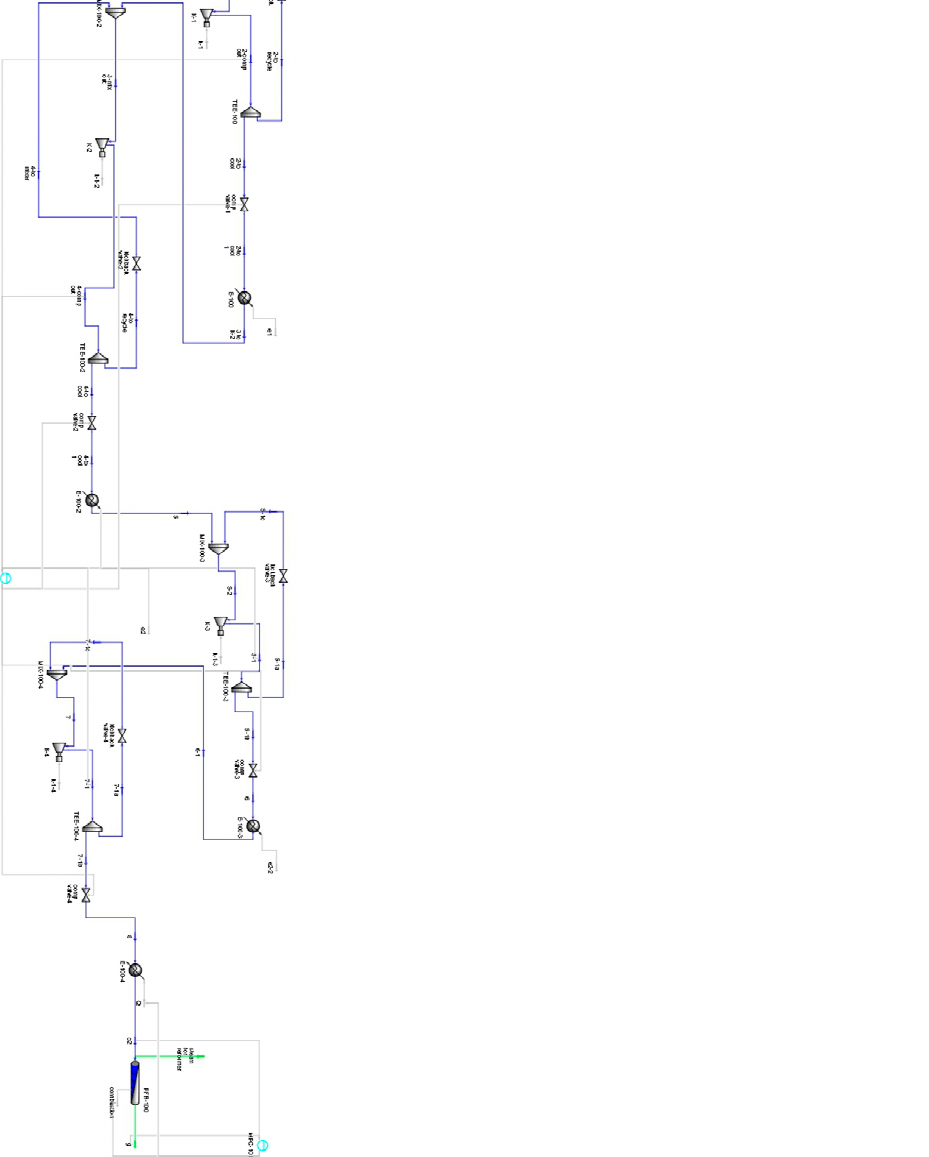
Figure 2. Process Flow diagram of compressor and steam reformer units in a biohydrogen plant.